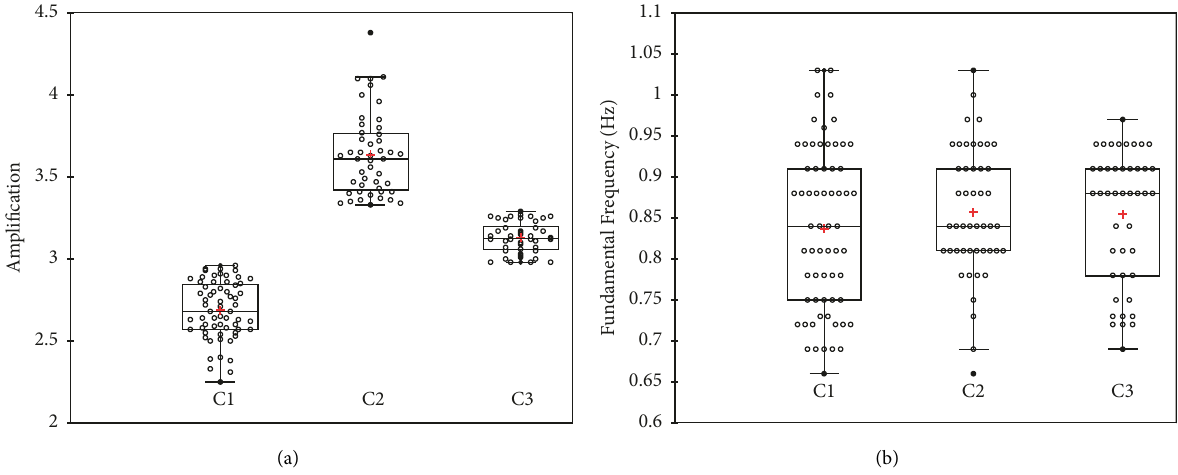
Figure 6: Box-plots showing the distribution of variables (a) Amplitude (Ao) and (b) Frequency (fo) by Hierarchical clustering